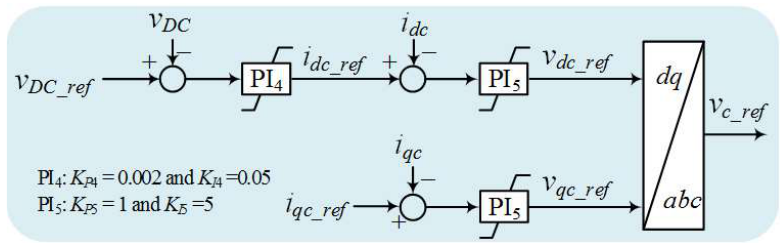
Figure 2. Diagram of the rotor side converter controller.